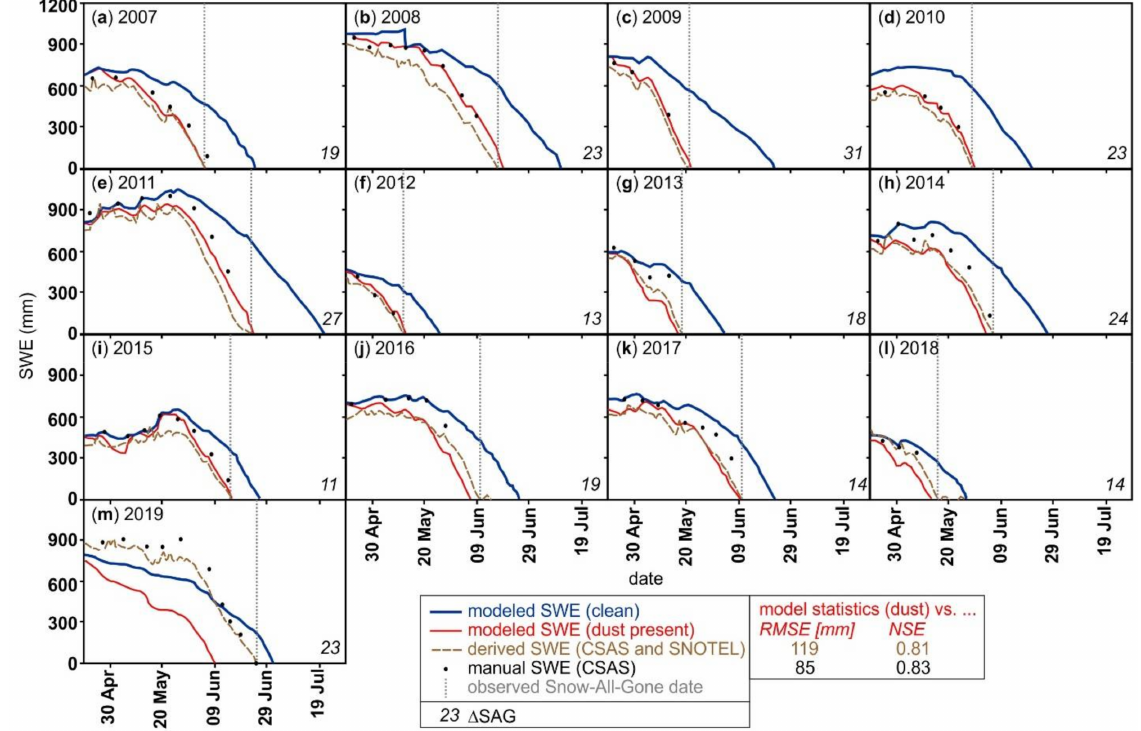
Figure 6. Modeled and observed SWE from mid-April to snowpack disappearance curves for snowmelt season ( a – m ) 2007 to 2019. SWE is simulated using the SNOBAL model for clean conditions (blue), dust-present conditions (red). Derived SWE is calculated from observed snow density at Red Mountain Pass SNOTEL and observed snow depth at CSAS study plot (dashed brown lines), and manually measured bulk SWE (black points). The date of the observed snow-all-gone is presented as a dotted vertical grey line. The modeled dust present vs. clean ( ∆ SAG) is presented in the lower right corner of each figure. The statistics of the model dust-present SWE vs. the derived and manual SWE observations are presented beside the legend as root mean square error (RMSE) and the Nash–Sutcliffe Efficiency (NSE)